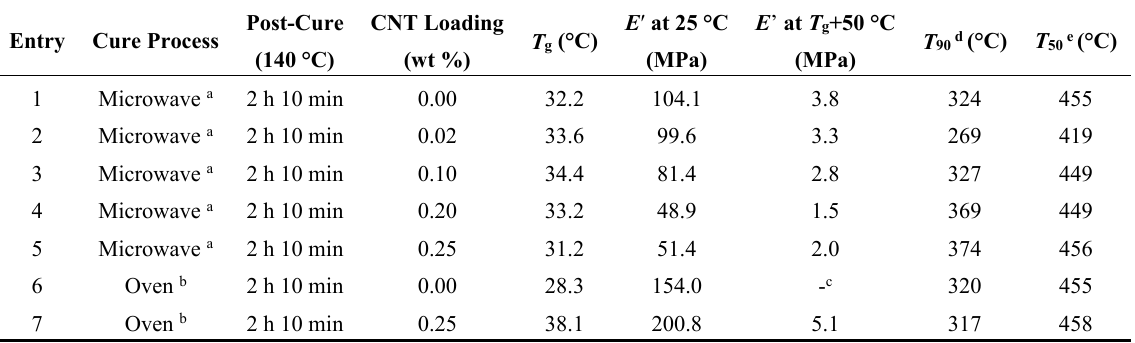
Table 2. Glass transition temperature ( T g ) and Storage modulus ( E ʹ ) at 25 °C as determined by dynamic mechanical analysis (DMA), and thermogravimetric analysis (TGA) results for samples cured either in a convection oven, or under